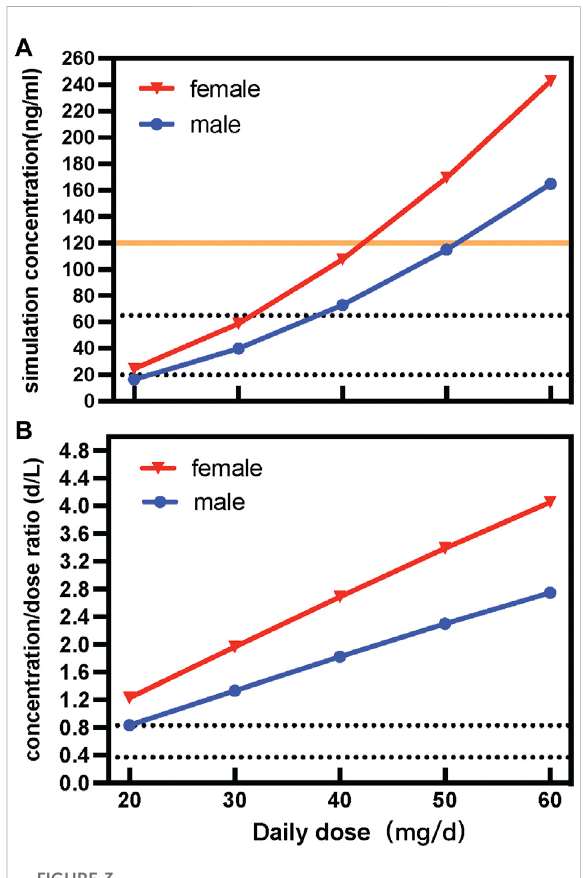
FIGURE 3 Simulated concentration (A) and dose-corrected serum concentrations (B) of different daily doses of immediate-release paroxetine tablet.